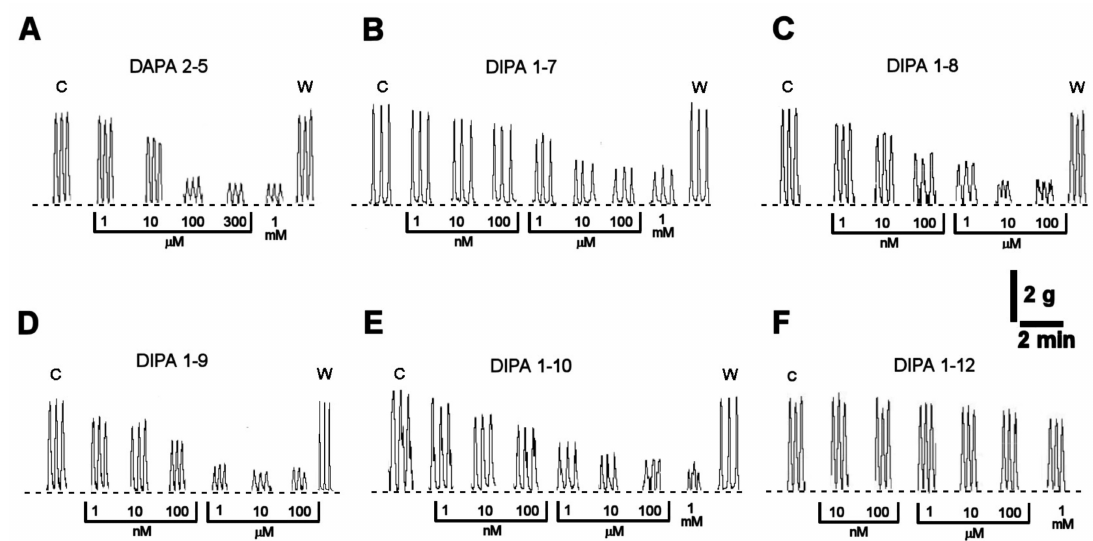
Figure 2. Typical recordings showing the inhibitory e ff ects of increasing concentrations of DAPA 2–5 (1 µ M–1 mM) ( A ), DIPA 1–7 (1 nM–1 mM) ( B ), DIPA 1–8 (1 nM–100 µ M) ( C ), DIPA 1–9 (1 nM–100 µ M) ( D ), DIPA 1–10 (1 nM–1 mM) ( E ), and DIPA 1–12 (10 nM–1 mM) ( F ) on the spontaneous contractions of human colon circular muscle. C = spontaneous contractions in control conditions. W = spontaneous contractions after washing out. Dotted line indicates the basal tone of the preparation.